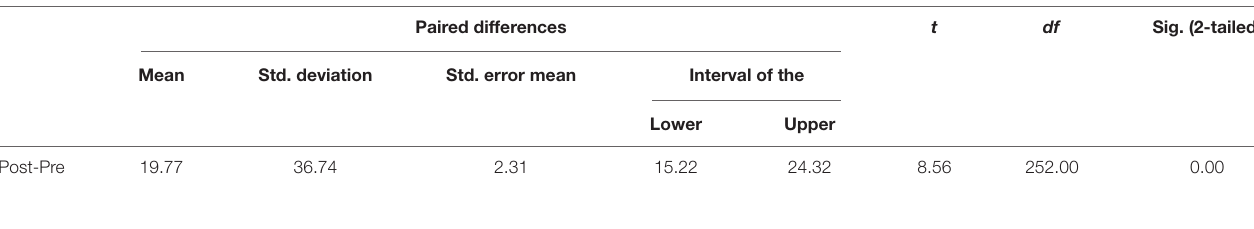
TABLE 2 | Paired mean differences sample test between pre- and post-tests in the first activity. Paired